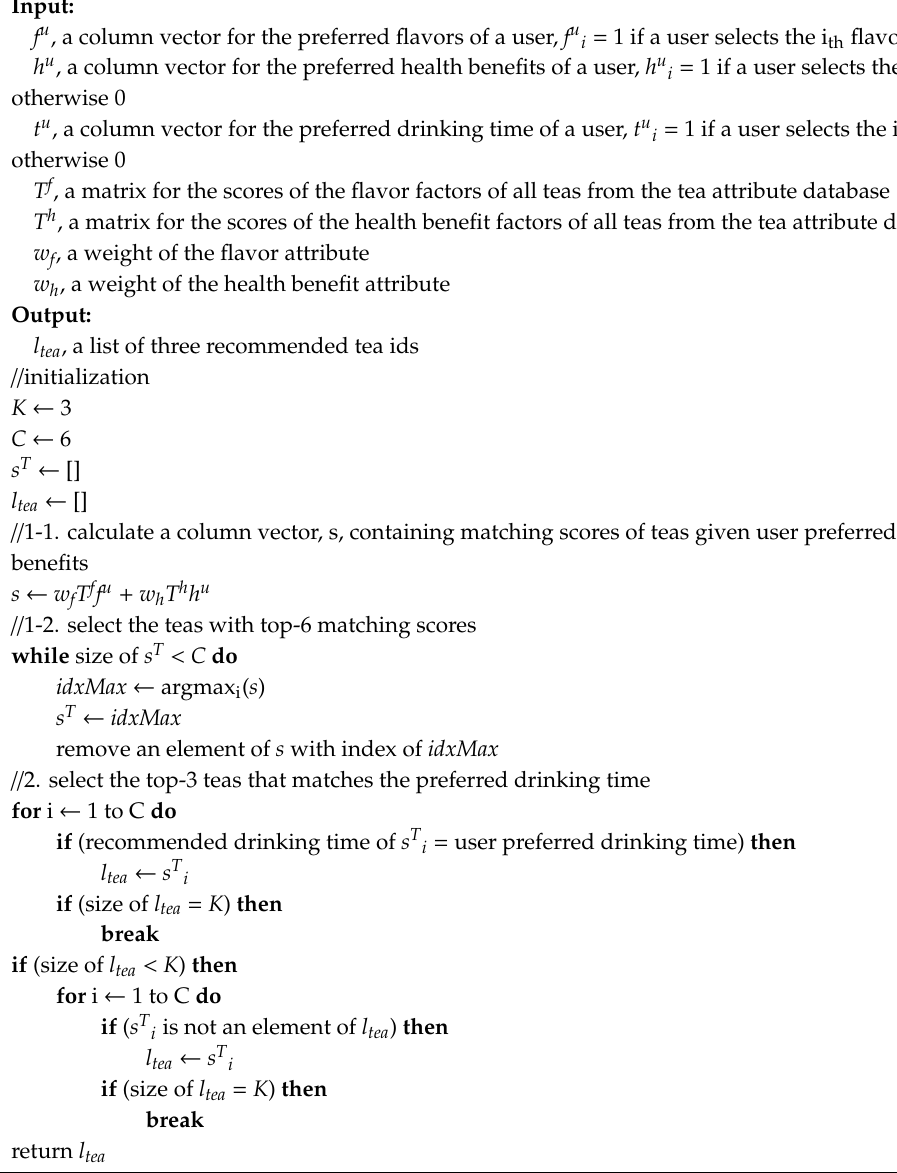
Algorithm 1 Recommended tea selection